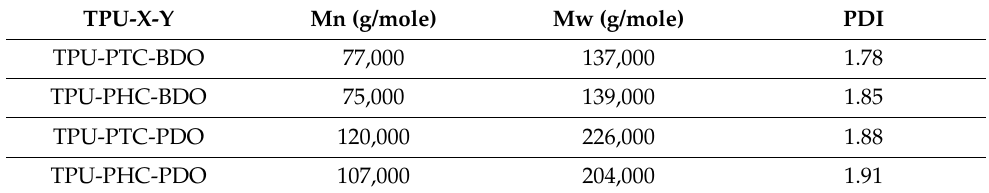
TPU ‐ PHC ‐ PDO 1.91 Mn: number ‐ average molecular weight; Mw: weight ‐ average molecular weight; PDI: polydisper ‐ Mn: number-average molecular weight; Mw: weight-average molecular weight; PDI: polydispersity index sity index (Mw/Mn).